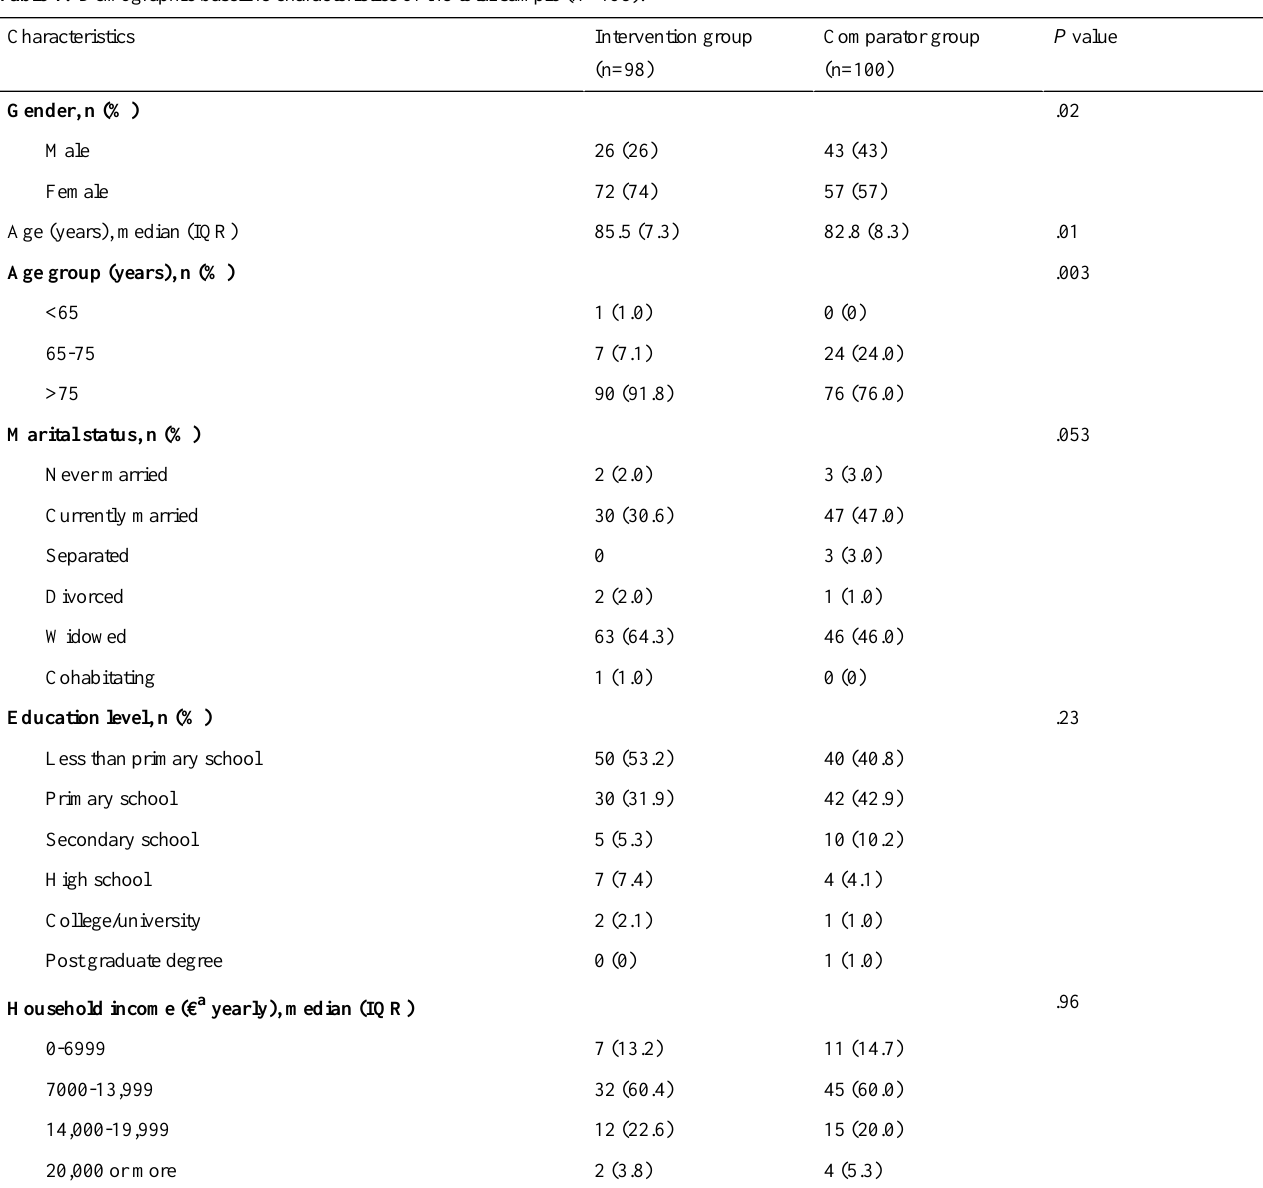
Table 1. Demographic baseline characteristics of the total sample